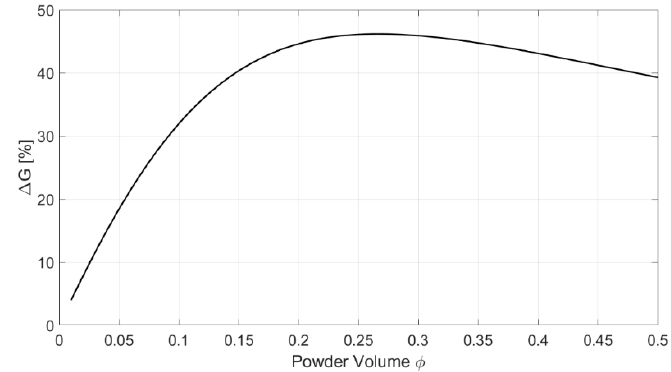
Figure 3. MR effect vs. powder volume fraction ϕ .